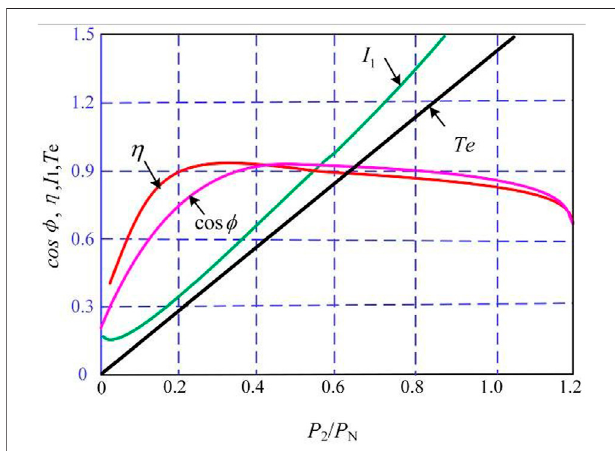
FIGURE 14 | Prototype operating characteristics in the LNG ( − 161 °